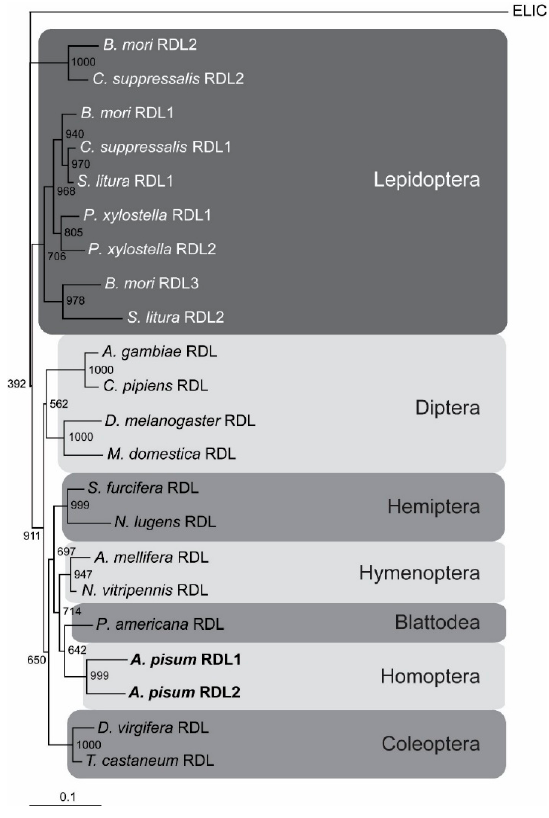
Figure 4. Tree showing relationships of RDL protein sequences from insects of various species. ELIC, which is an ancestral cysLGIC from the bacterium Erwinia chrysanthemi [29], was used as an outgroup. Numbers at each node signify bootstrap values with 1000 replicates, and the scale bar represents substitutions per site. A. pisum RDLs are shown in boldface type.